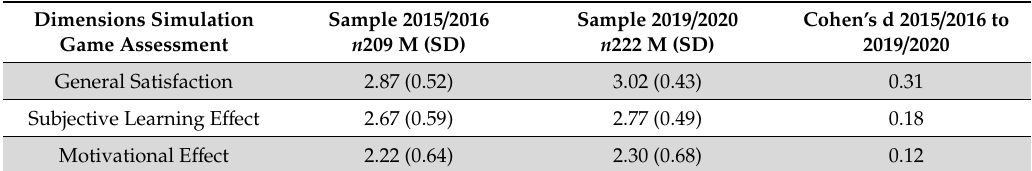
Table 5. Mean Value Comparison of All Three Dimensions of Simulation Game Assessment in the First and Last Evaluation Cycles.